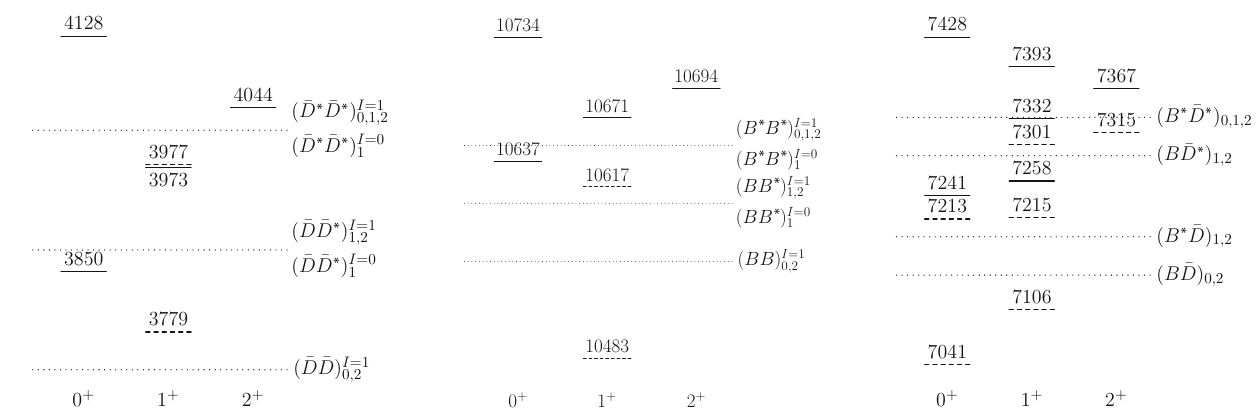
Fig. 2 The estimated masses (units: MeV) of the nn ¯ c ¯ c (left), nn ¯ b ¯ b (middle), and nn ¯ c ¯ b (right) systems in the threshold scheme. The solid (dashed) lines correspond to the I = 1 ( I = 0) case. The dotted lines are thresholds of the possible decay channels. When the isospin con-